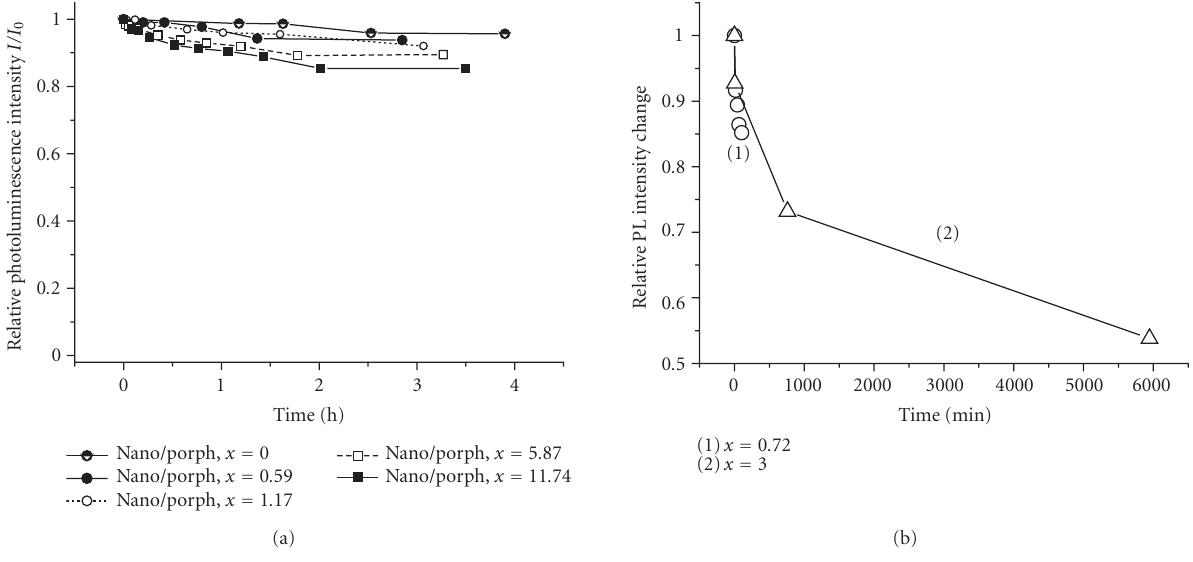
Figure 3: (a) PL quenching of Hops Yellow (CdSe / ZnS QD, Evident) in toluene as a function of waiting time after one titration step by (m − Pyr) 4 H 2 P at various molar ratios ( x ). All data have been normalized to 1 at t = 0. (b) PL quenching of Lace Placid Blue (CdSe QD, Evident) in toluene as function of waiting time after one titration step by (m − Pyr) 4 H 2 P at x = 0 . 72 (1) and x = 3 (2). Data have been normalized to 1 at t = 0.